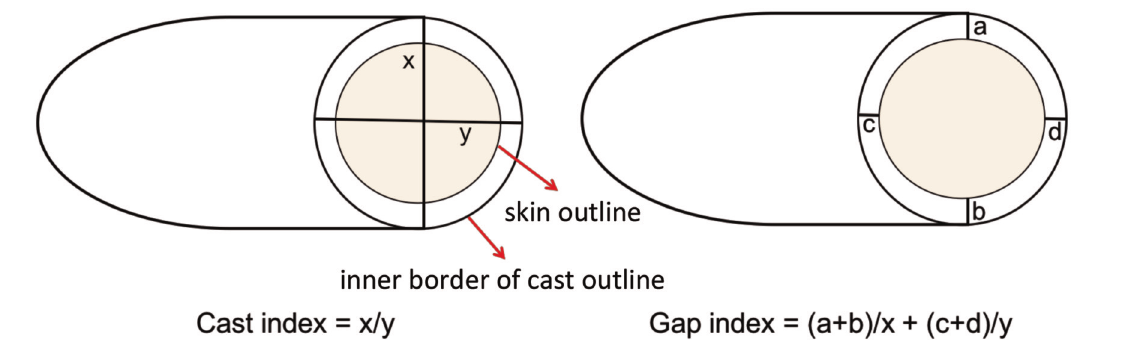
x= Distance between inner border of the plaster/cast at the fracture/moulding site in lateral view. y= Distance between inner border of the plaster/cast at the fracture/moulding site in AP view. a= Distance between identifiable outline of skin and inner border of the plaster/cast at the fracture/moulding site (Anteriorly in AP view) b=Distance between identifiable outline of skin and inner border of the plaster/cast at the fracture/moulding site (Posteriorly in AP view). c= Distance between identifiable outline of skin and inner border of the plaster/cast at the fracture/moulding site (Medially in lateral view). d=Distance between identifiable outline of skin and inner border of the plaster/cast at the fracture/moulding site (Laterally in lateral view). Measurement of cast index and gap Fig. 3: